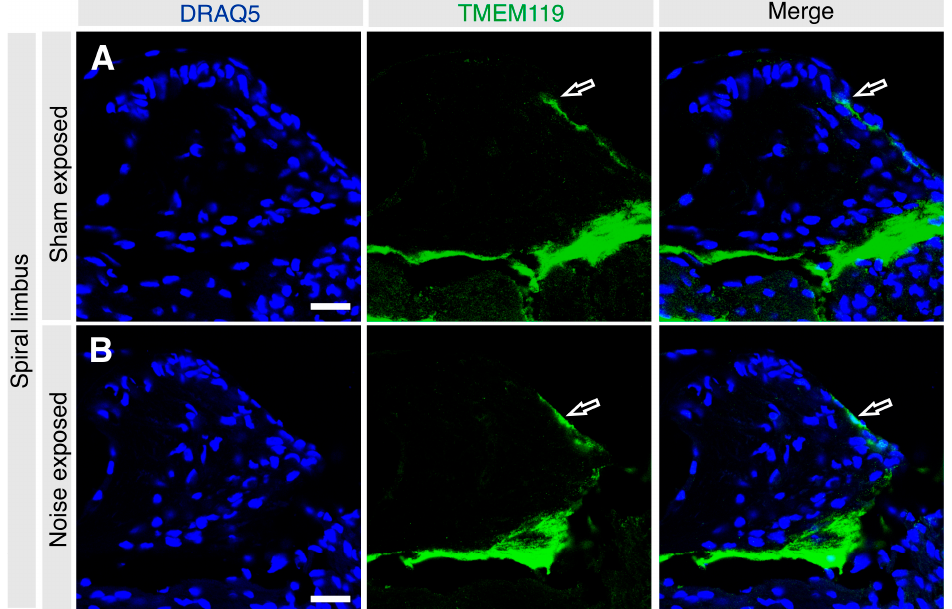
Figure 6. High magnification confocal microscopic images of the spiral limbus in sham-exposed ( A ) and noise-exposed ( B ) adult cochleae labeled for TMEM119 (green) and counterstained with DRAQ5 (blue). TMEM119 protein was detected in both groups’ mesenchymal cells of the supralimbic zone (hollow white arrows). Scale bar: 20 µm.